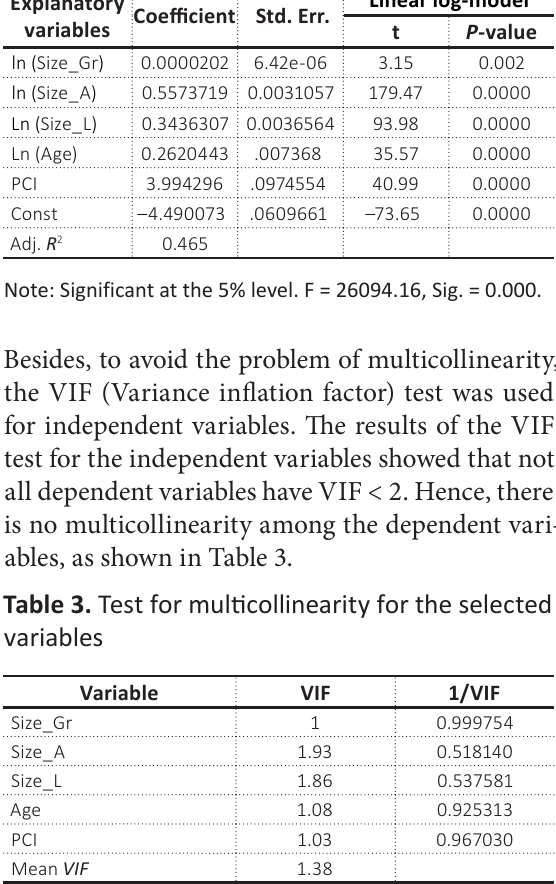
Table 2. Final estimation result Explanatory